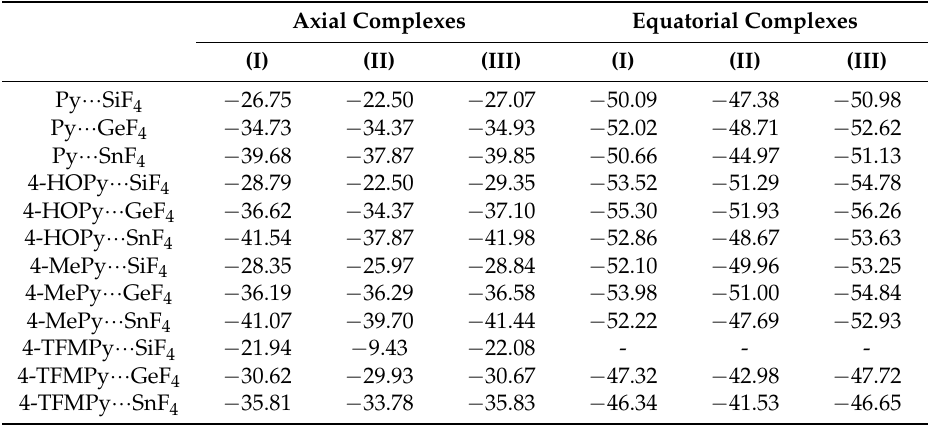
Table 4. Interaction energies (E int , kcal mol − 1 ) corrected for BSSE calculated at the MP2/cc-pVTZ (I), BLYP-D3/Def2TZVPP (II), and CCSD(T)/cc-pVTZ (III) levels of theory.